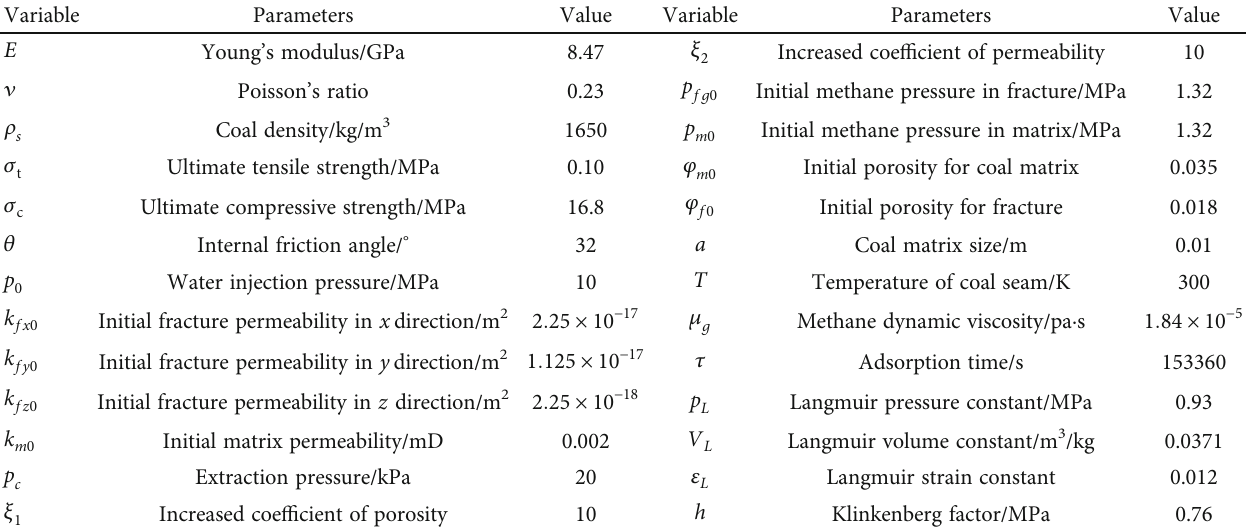
Table 1: Parameters for numerical simulation.